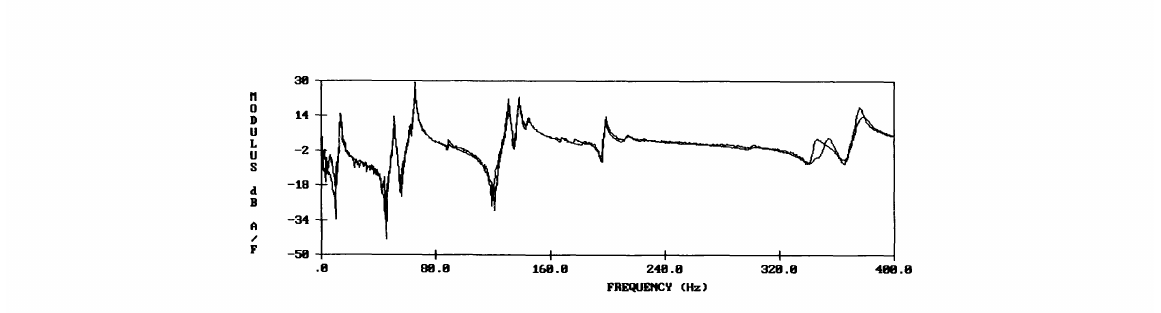
FIGURE 6 Dynamic response of two nominally identical exhaust systems, case study